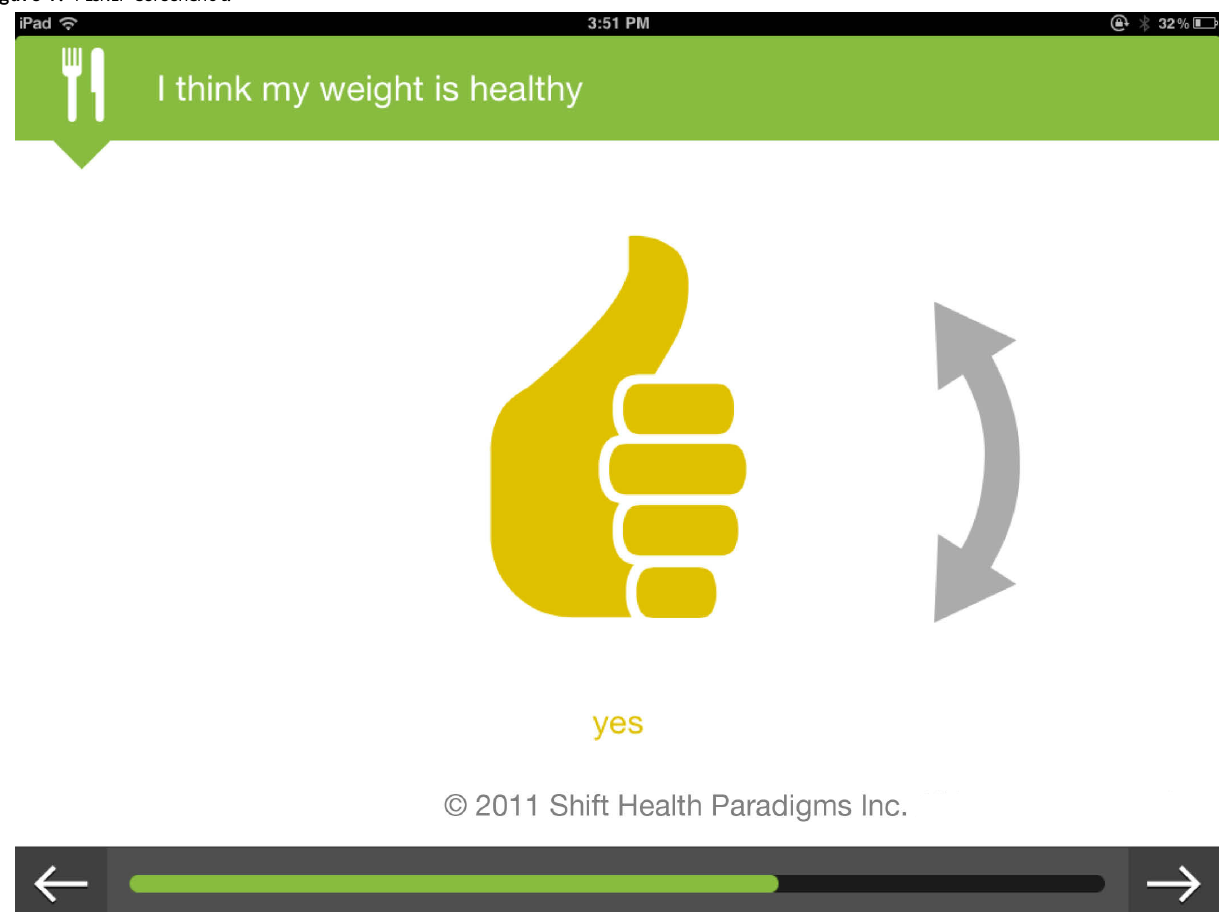
Figure 4. TickiT